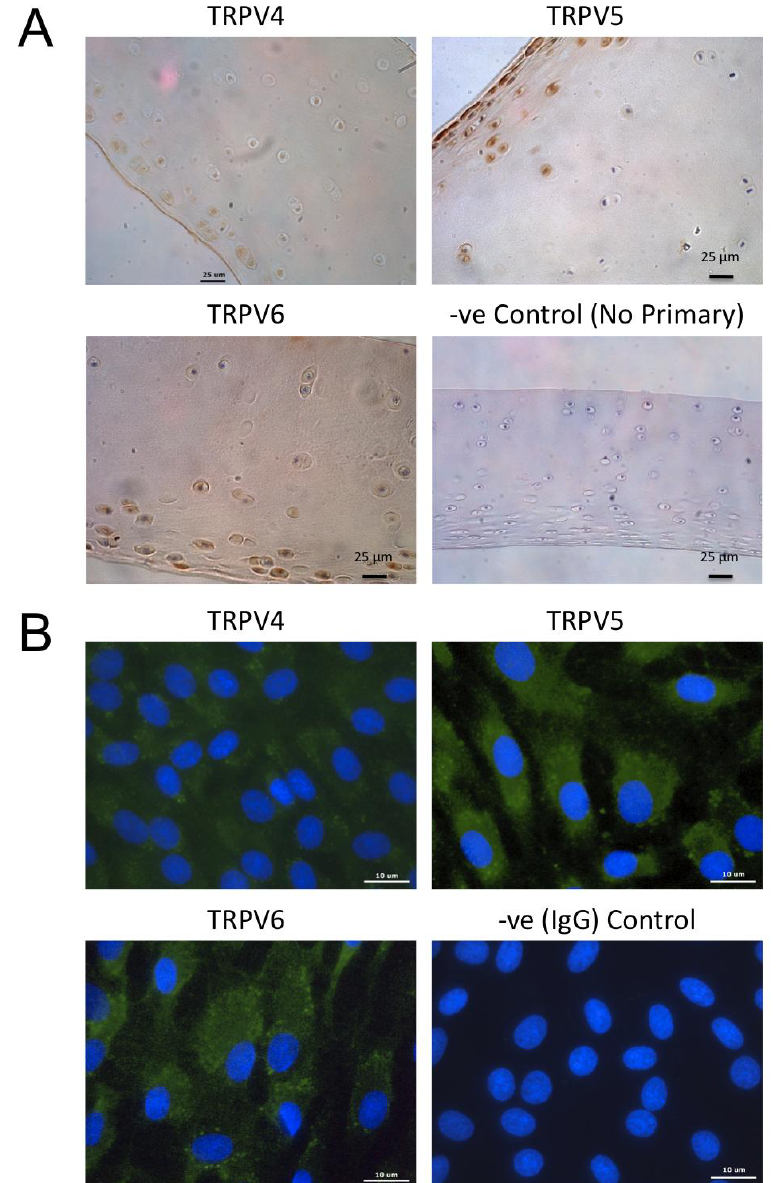
Figure 1. ( A ) Localization of transient receptor potential vanilloid (TRPV) channel isoforms (TRPV4, TRPV5 and TRPV6) in equine articular cartilage. Sections of equine articular cartilage were immunostained using polyclonal antibodies raised against TRPV4, TRPV5 or TRPV6. All three channels showed positive immunoreactivity in chondrocytes from the superficial zone of equine articular cartilage. The negative control shown was treated using the same immunohistochemical protocol, but the primary antibody step was omitted; ( B ) Cellular and subcellular localization of TRPV4, TRPV5 and TRPV6 in monolayer cultures of methanol fixed P2 chondrocytes. All three channels showed positive immunoreactivity (green fluorescent staining) within P2 chondrocytes. The negative control was exposed to nonimmune rabbit IgG and shows blue fluorescent nuclear staining only. Nuclei were counterstained with DAPI (blue fluorescent